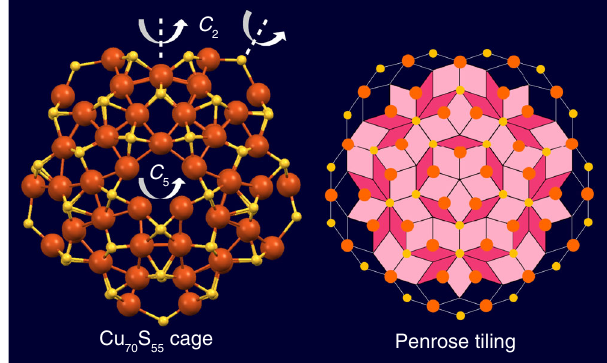
Fig. 3 Structure of the Cu 70 S 55 cage. Top view along the C 5 axis (left); and a Penrose tiling with joint points marked by orange and yellow solid circles to represent Cu and S, respectively (right). Color labels: orange = Cu, yellow =